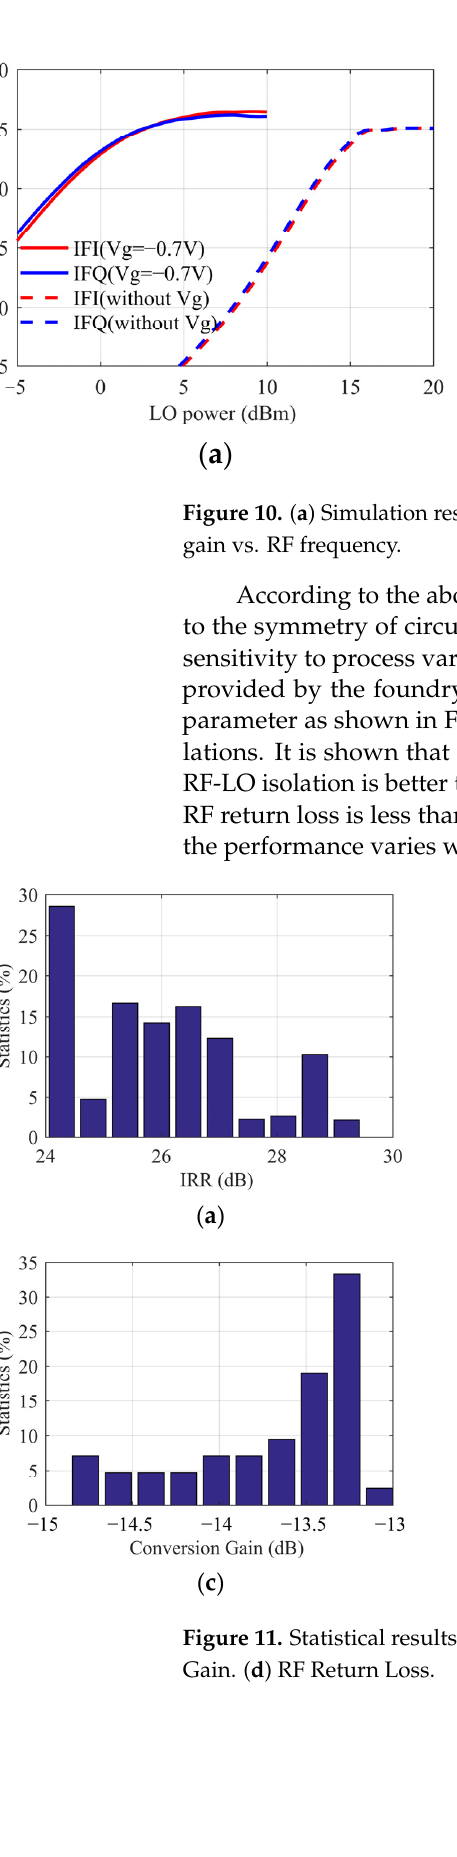
Figure 11. Statistical results of Monte Carlo simulation ( a ) IRR. ( b ) RF-LO isolation. ( c ) Conversion Gain. ( d ) RF Return Loss.